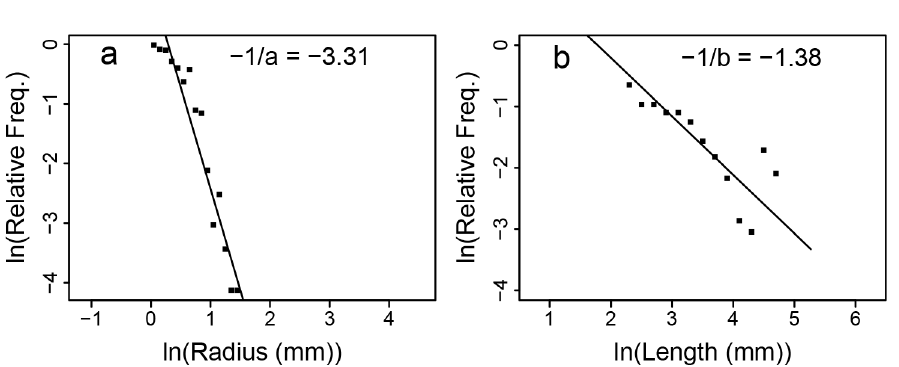
Fig 3. Distribution-Based Exponent Fits. Standard Major Axis regression (see Methods) of the natural log of relative frequency (probability density) against (a) the log of radius, ln r , and (b) the log of length, ln l . Fit lines and slope values are shown. The correlation coefficient ( R 2 ) for the log relative frequency versus the logs of radius and length respectively are 0.90 and 0.68.